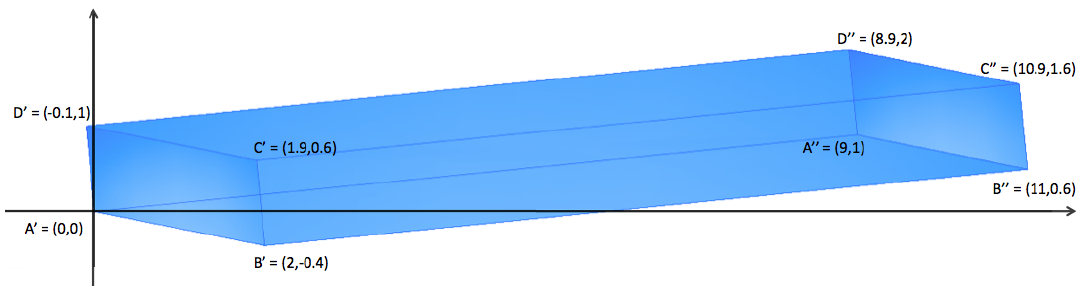
Figure 3. Payoff space of the entire coopetitive game: collection of all possible payoff scenarios, in a full coopetitive framework, with the tonnage z varying in [0, 5].